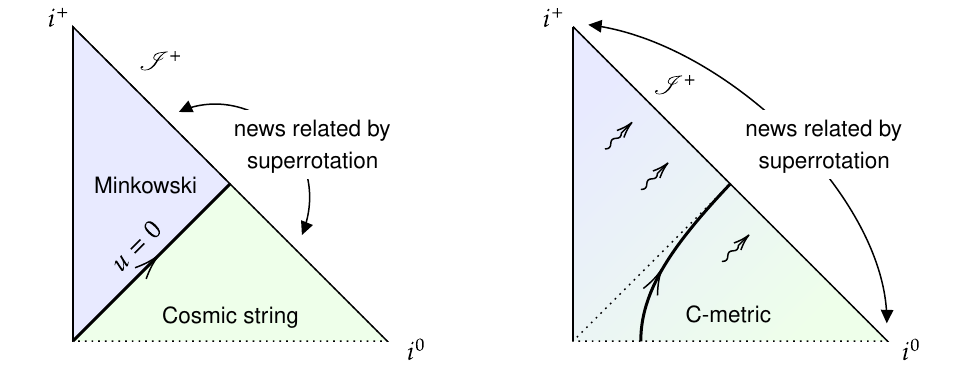
Figure 1 . A portion of the Penrose diagram for the snapping cosmic string considered in [82] is shown on the left. The green area represents the infinite cosmic string metric, which is glued to a Minkowski patch (in blue) along u = 0 . The trajectory of the endpoints is represented by the thick line. On the right is the corresponding picture for the (linearised) C-metric. In this case, we have radiation approaching I + . Note that the true Penrose diagram for the C-metric is more involved